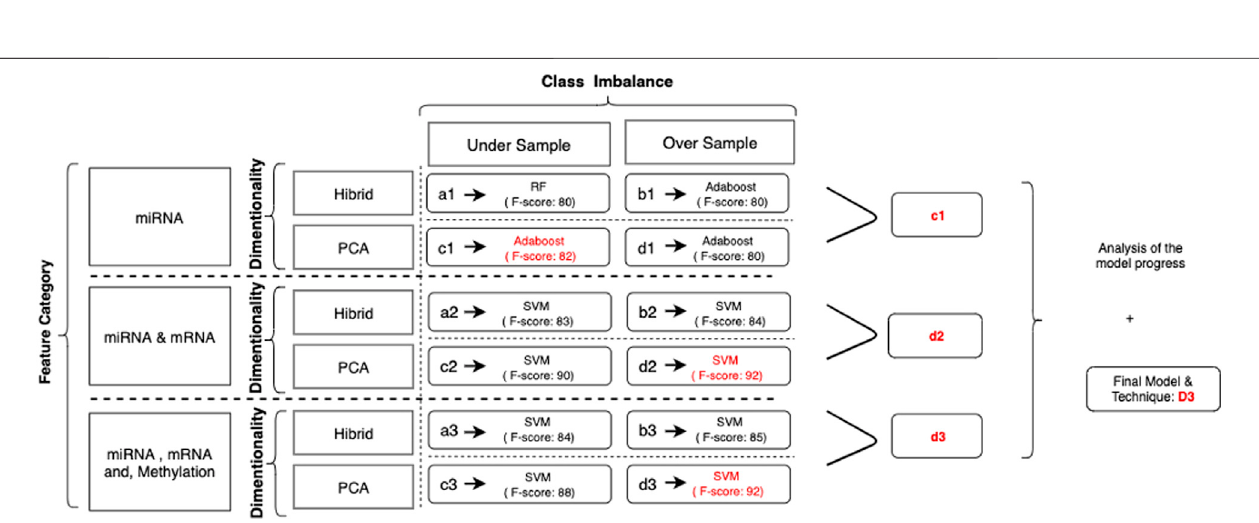
FIGURE5| Illustrationforresultsofcategory-basedanalysiswithtechniquesappliedtosolvesigni fi cantissues:asaresultoftheevaluationprocess,(c1)isselected as the successor model for miRNA markers. When two markers, miRNA and mRNA, are combined, the winner is identi fi ed as (d2). In the fi nal cycle, the merge of all biomarkers resulted in (d3) as the successor. Among all, (d3) was the winner to predict the metastatic outcome.